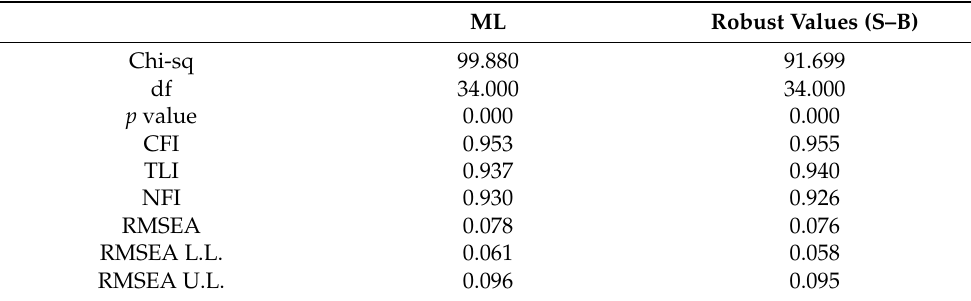
Figure 1. Model CFA for the GOEM scale. Table 1. The GOEM scale model fitting indices to empirical data.